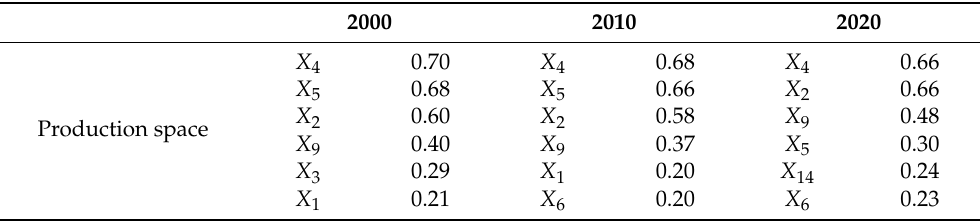
Table 6. Driving factors of territorial spatial evolution in the Yangtze River Economic Belt, 2000–2020 (Top 6).